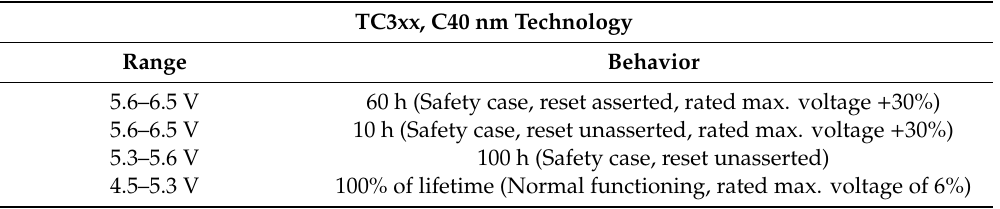
Table 1. Microcontroller supply operation